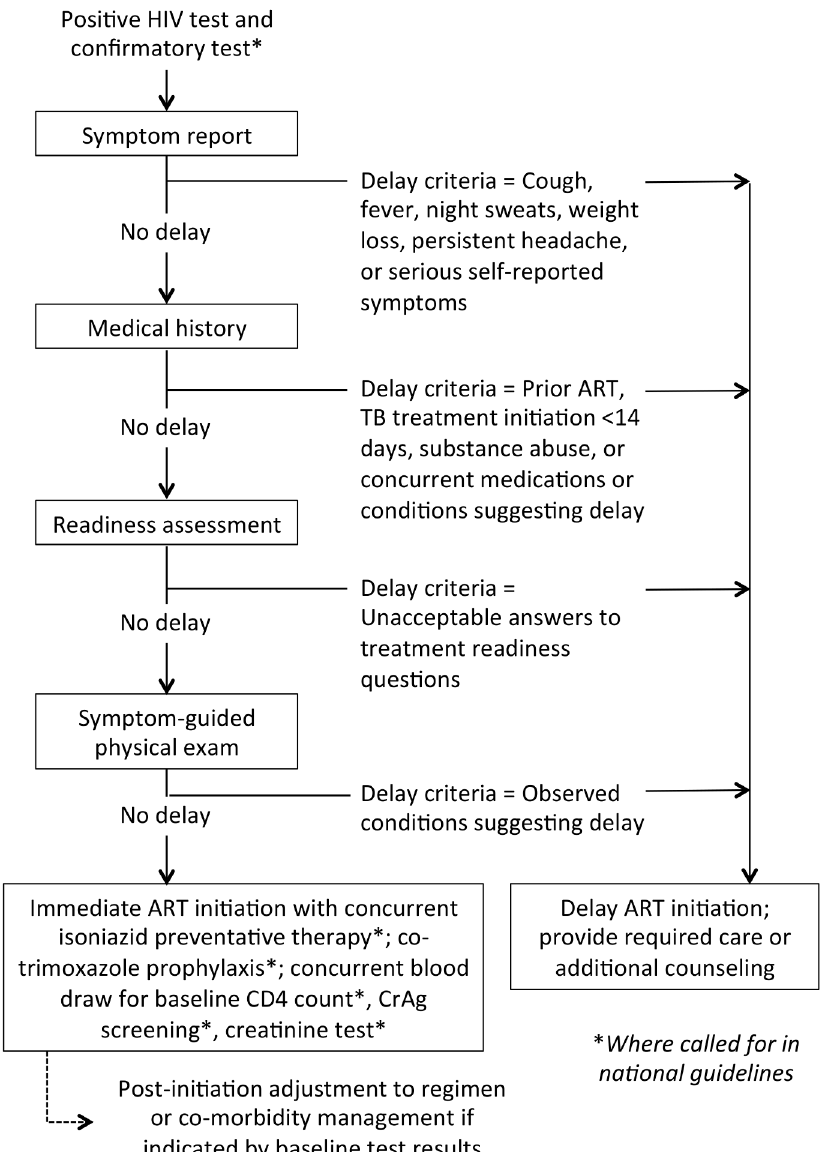
Fig 1. Determining clinical eligibility for immediate ART initiation: proposed algorithm for evaluation in the research agenda. Diagram showing the steps that could be included in an algorithm to evaluate whether HIV-positive patients are eligible for immediate ART initiation or instead require additional care or services before medications are dispensed. The MATI consultation recommended that this algorithm be evaluated in research studies. CrAg, cryptococcal